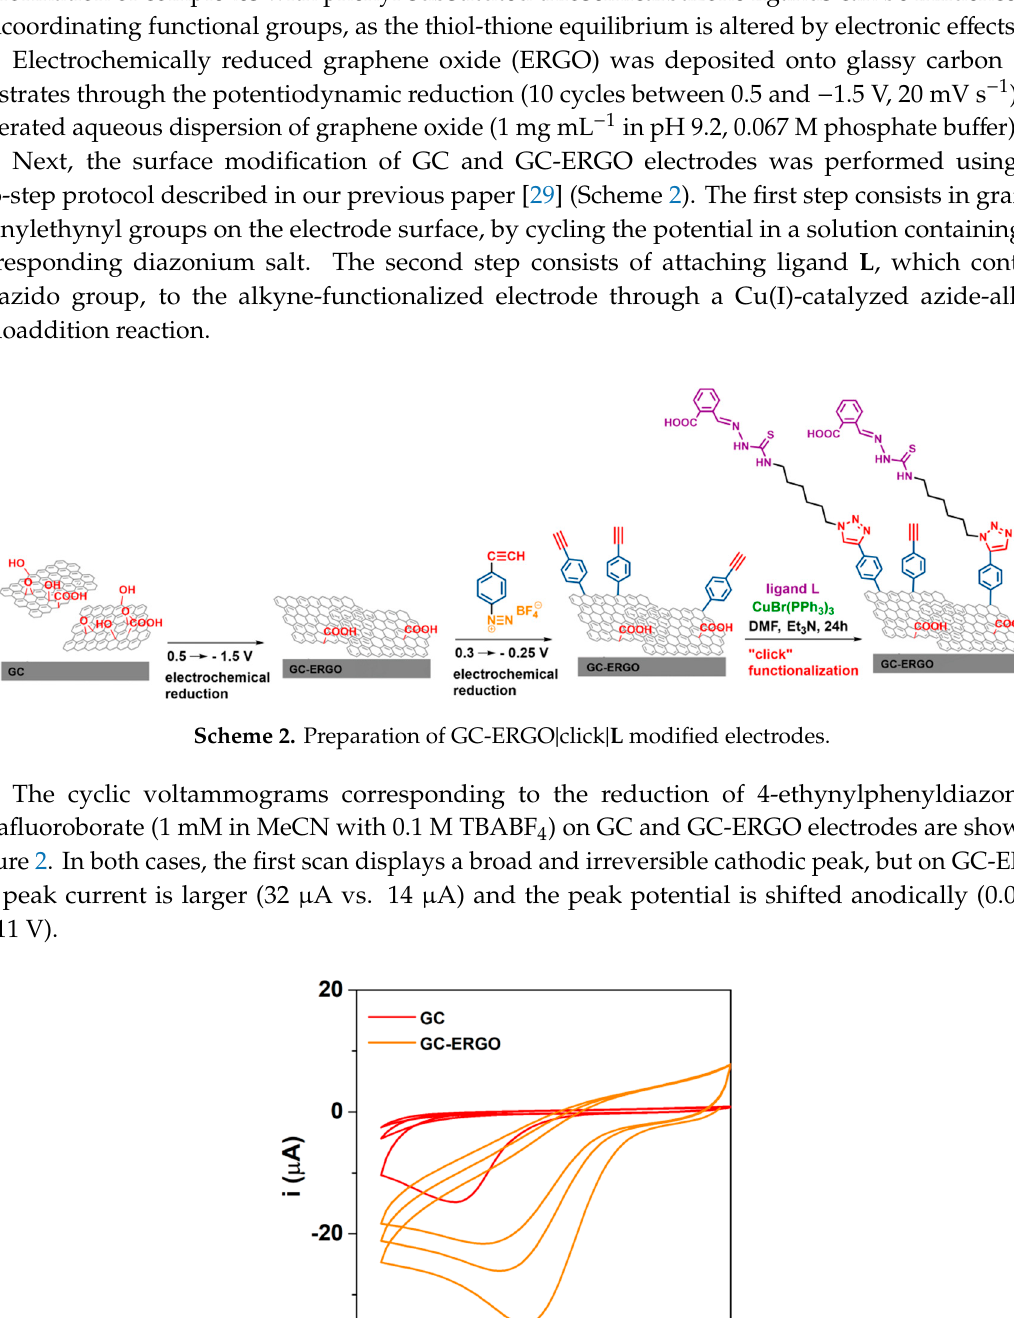
Figure 1. UV-VIS spectra of ligand L before and after the addition of 1 equivalent of heavy metal ions.